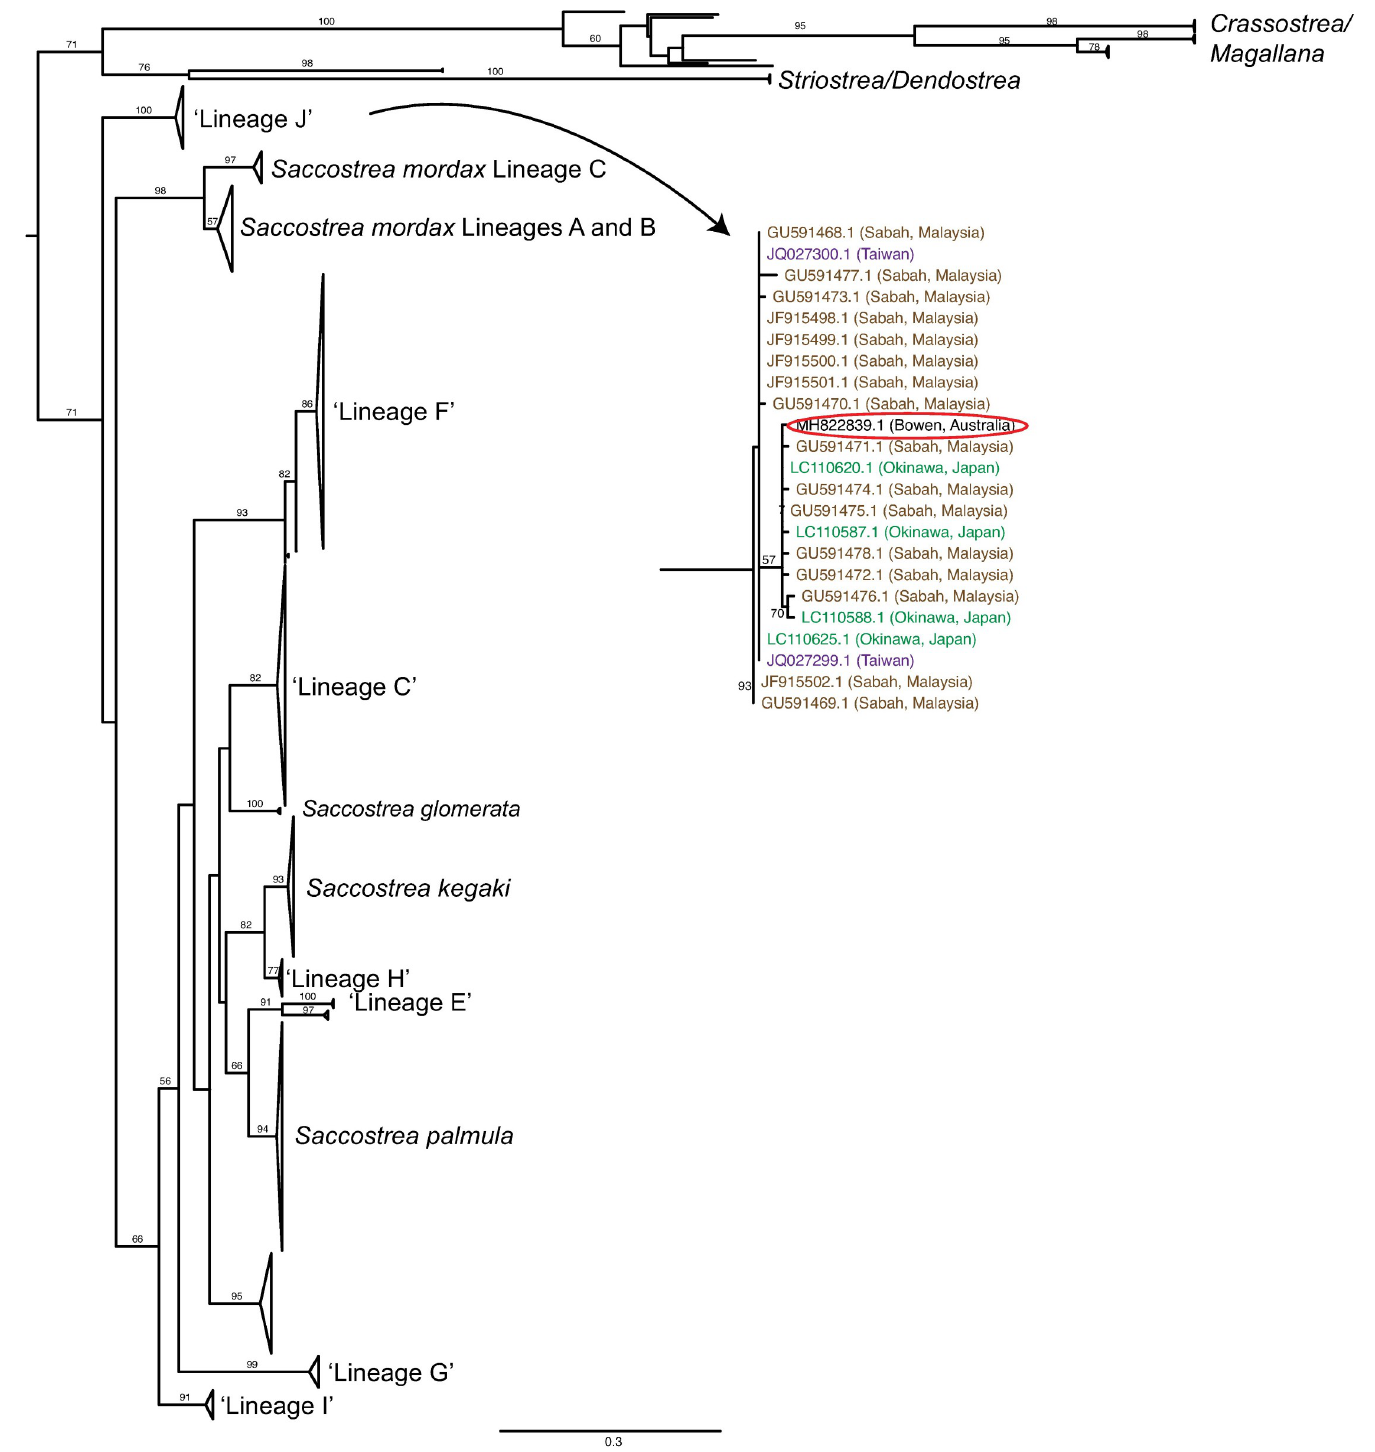
Fig 2. Maximum likelihood phylogenetic analysis of Saccostrea COI sequences. Bootstrap values > 50 are given on branches, and the scale bar indicates the number of substitutions per site. The clade containing Striostrea , Dendostrea , Magallana and Crassostrea COI sequences is used as an outgroup. Lineages have been designated (where possible) following Lam and Morton [11] and Sekino and Yamashita [12]. The Bowen black-lip COI sequence (circled in inset) falls within ‘Lineage J’ with strong support.